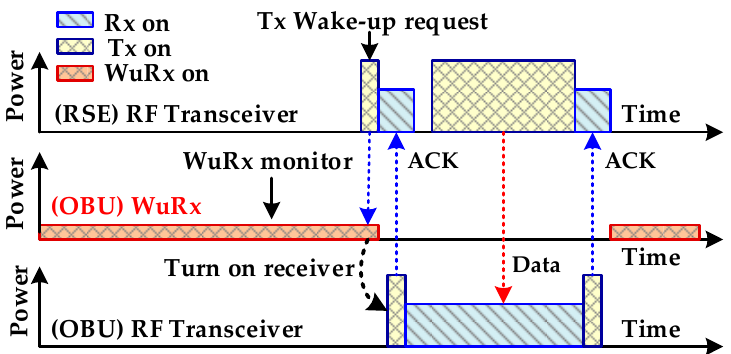
Figure 3. The road side equipment (RSE) and OBU pure asynchronous communication with the RF wake-up receiver (WuRx).